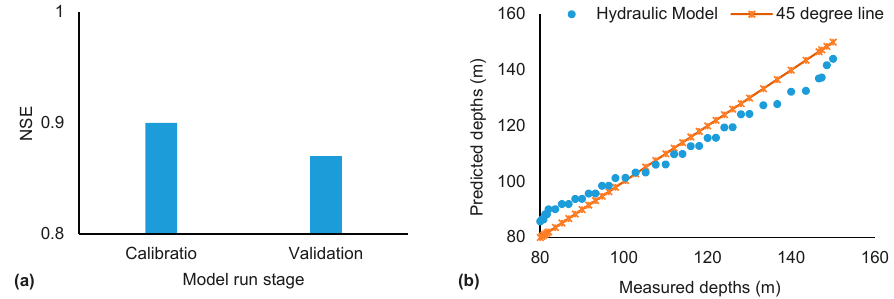
Figure 7. Results of MODFLOW ( a ) Performance parameter NSE, ( b ) Predicted vs observed water depths.